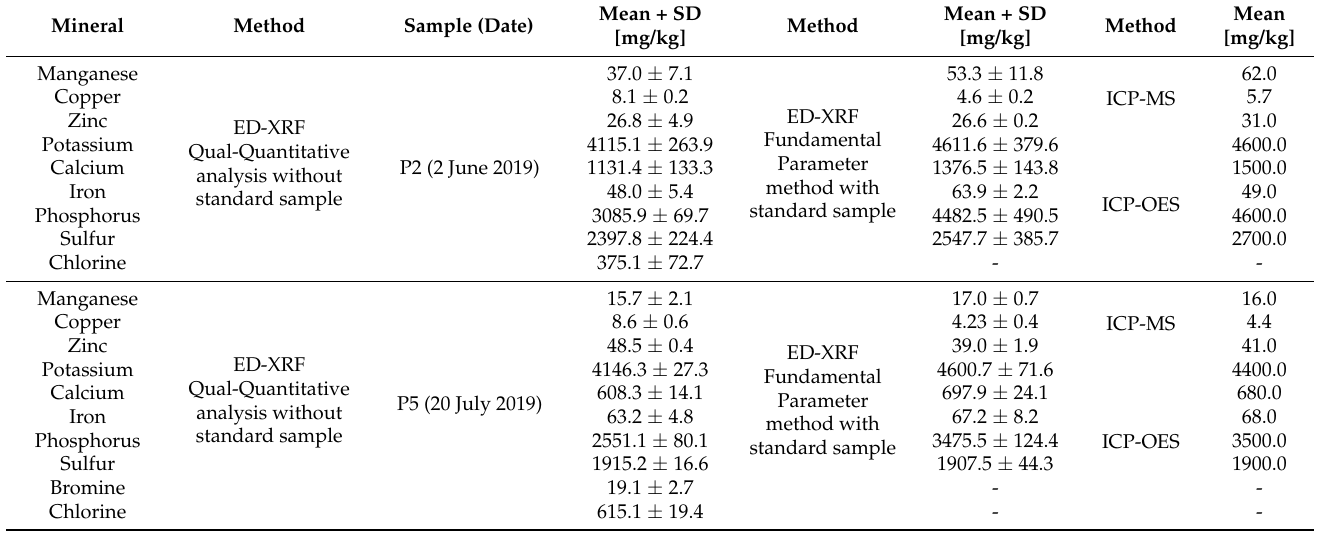
Table 1. Comparison of the mineral content results obtained using different analytical methods (ED-XRF qualitative– quantitative, ED-XRF with standard sample, and ICP-MS/ICP-OES) for bee pollen samples collected on 2 June 2019 (P2) and 20 July 2019